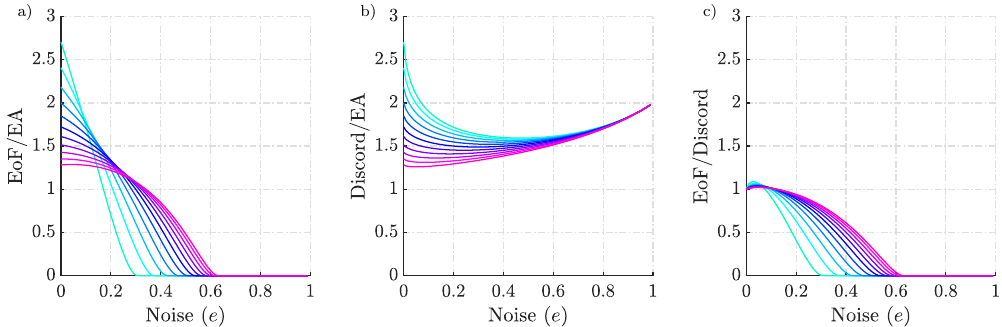
Figure 5. Comparison of EA with EoF and discord for pure states with white noise. Each colour represents how noise affects the correlation measures for a given pure state parametrised by the Schmidt angle θ . The pink π/ 4 ) whereas cyan represents states that are not colour represents the pure states that are highly entangled ( θ → 0 ). At all times EA is less than or equal to discord. Whereas EA is only greater than EoF highly entangled ( θ → when the degree of noise present in the mixture is significant.